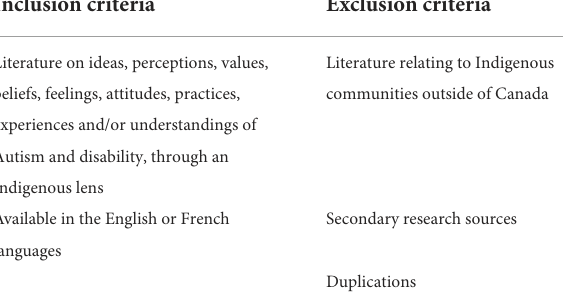
TABLE 1 Inclusion and exclusion criteria for scholarly literature review on the beliefs and perceptions of autism within indigenous communities in